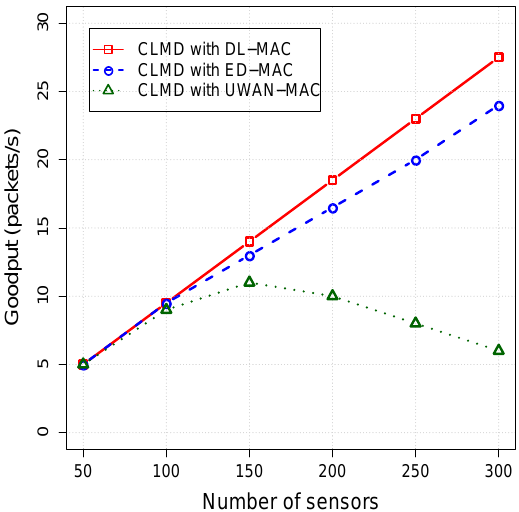
Figure 8. Goodput vs. node density.